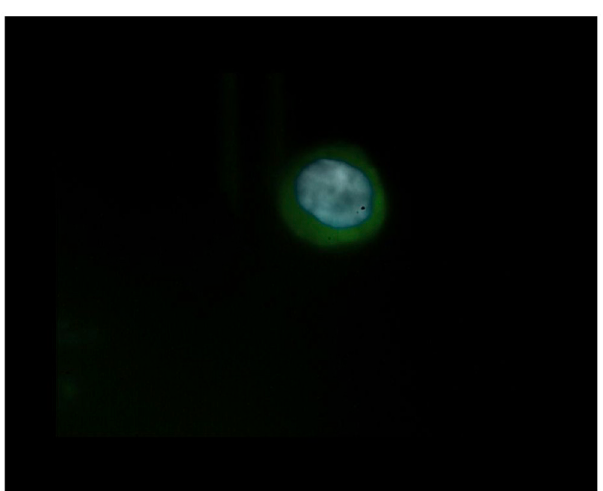
Fig 3. Image of CTC in patient sample using Parsortix. Immunofluorescence microscope showing a CTC in a patient sample with an irregular and larger cell nucleus (Hoechst nucleus staining (blue)) and in comparison lower volume of cell membrane (FITC-CK (green)). Staining for CD45-APC (red) was negative.